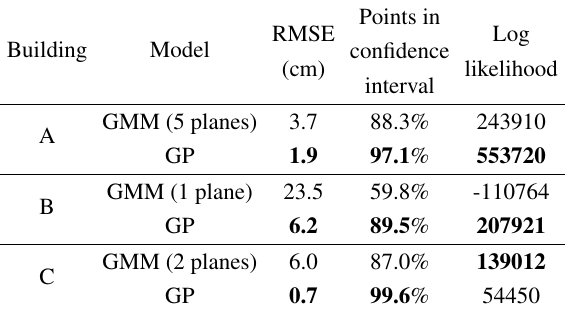
Table 1. Evaluation of the errors and uncertainties.